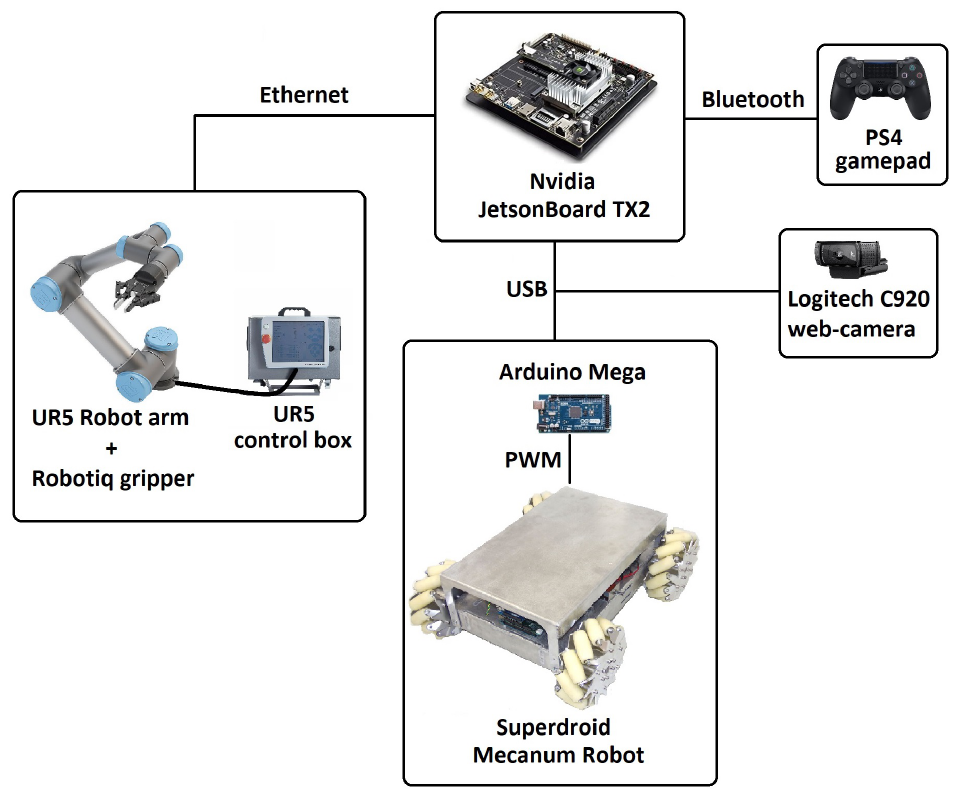
Figure 2. Global hardware architecture of the Autonomous Charging Station. As for the robot arm, it has two operation modes: local and remote modes. The local mode allows the manual control or direct programming of the arm using the teaching pendant (the touchscreen that comes with the arm). When using the remote mode, the robot arm control box receives operation commands through network requests. To this end, the communication with the robot arm is ensured via the low-level networking interface ( socket ) [27]. More information about this mode of communication can be found in [28]. The communication between the ACS and the AEV is ensured via websockets. To this end, both roslibpy [29] and rosbridge_suite [30] to establish the communication, and allow inter-vehicle